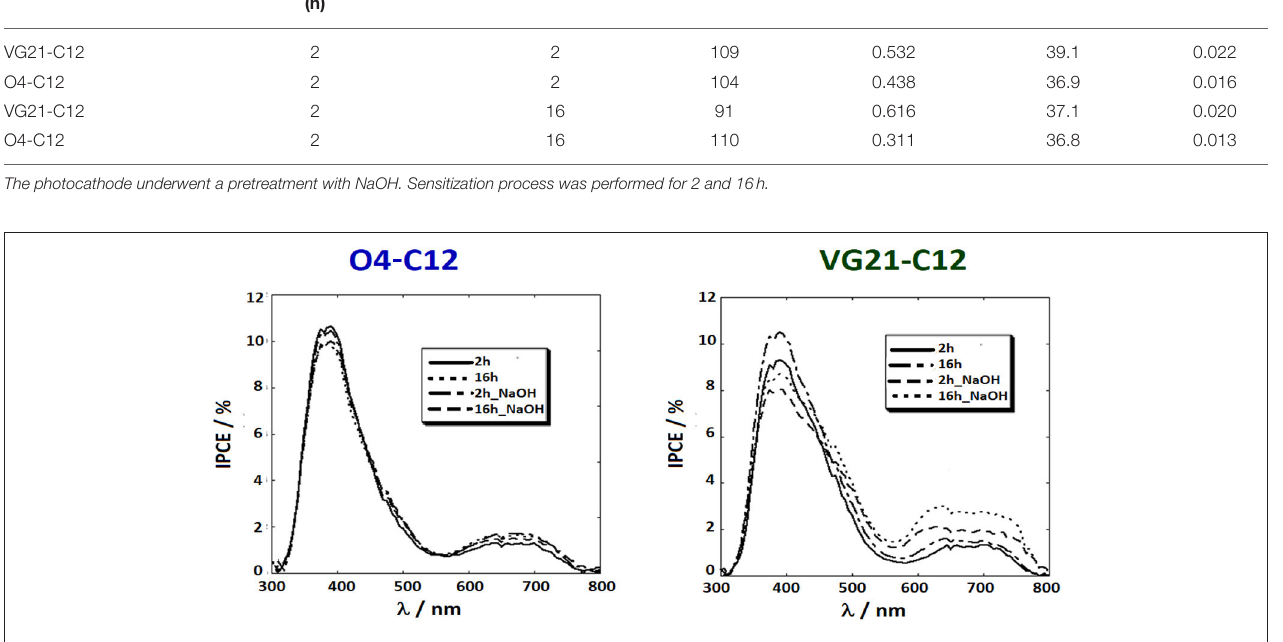
TABLE 3 | Photoelectrochemical parameters of VG21-C12 and O4-C12-sensitized NiO-based DSCs. Dye Pretreatment time with NaOH Sens. time (h) V OC (mV) (h) VG21-C12